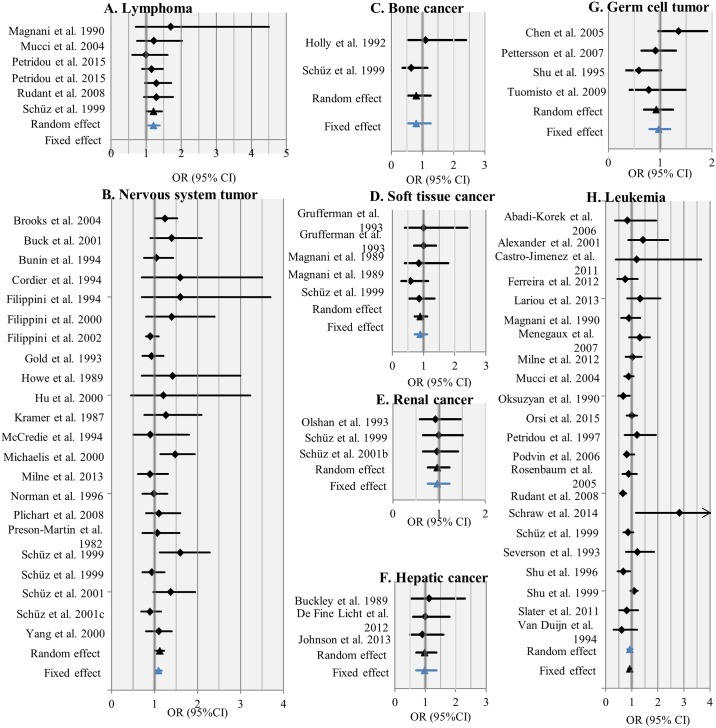
Meta-analyses based on 62 original research articles for eight cancer types and any smoking during pregnancy (yes vs no).The final model selected according to heterogeneity analyses is indicated in blue. CI = Confidence Interval.